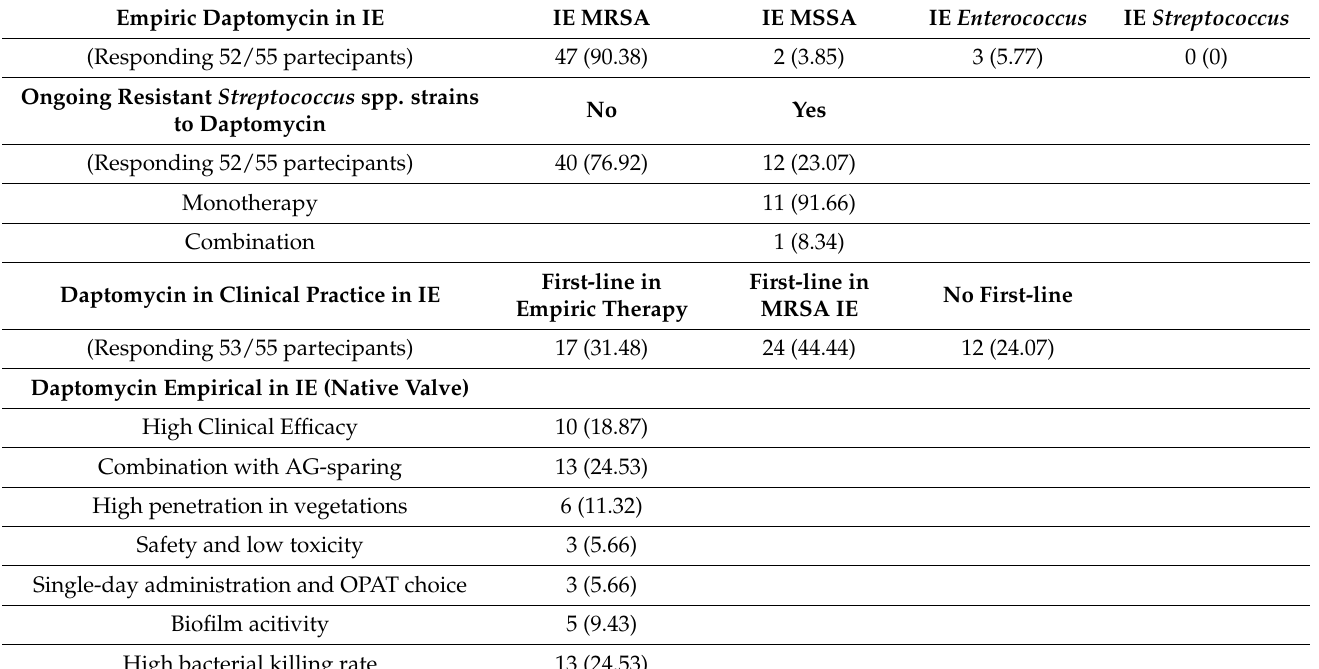
Table 4. Empirical, targeted combination therapy or monotherapy including Daptomycin in different settings: responses from enrolled